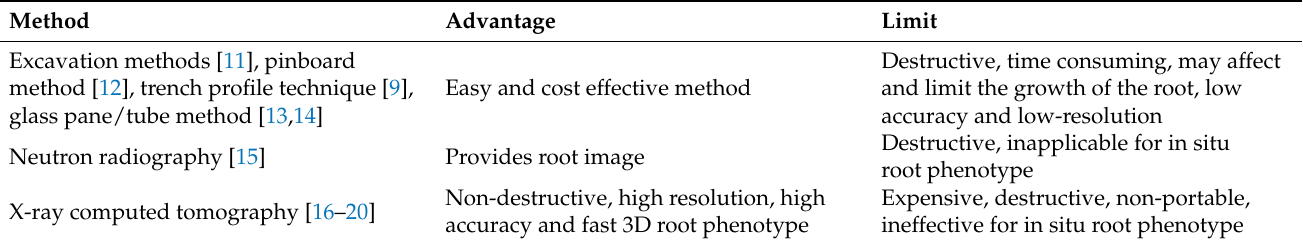
Table 1. Advantages and limits of the pre-existing root phenotype